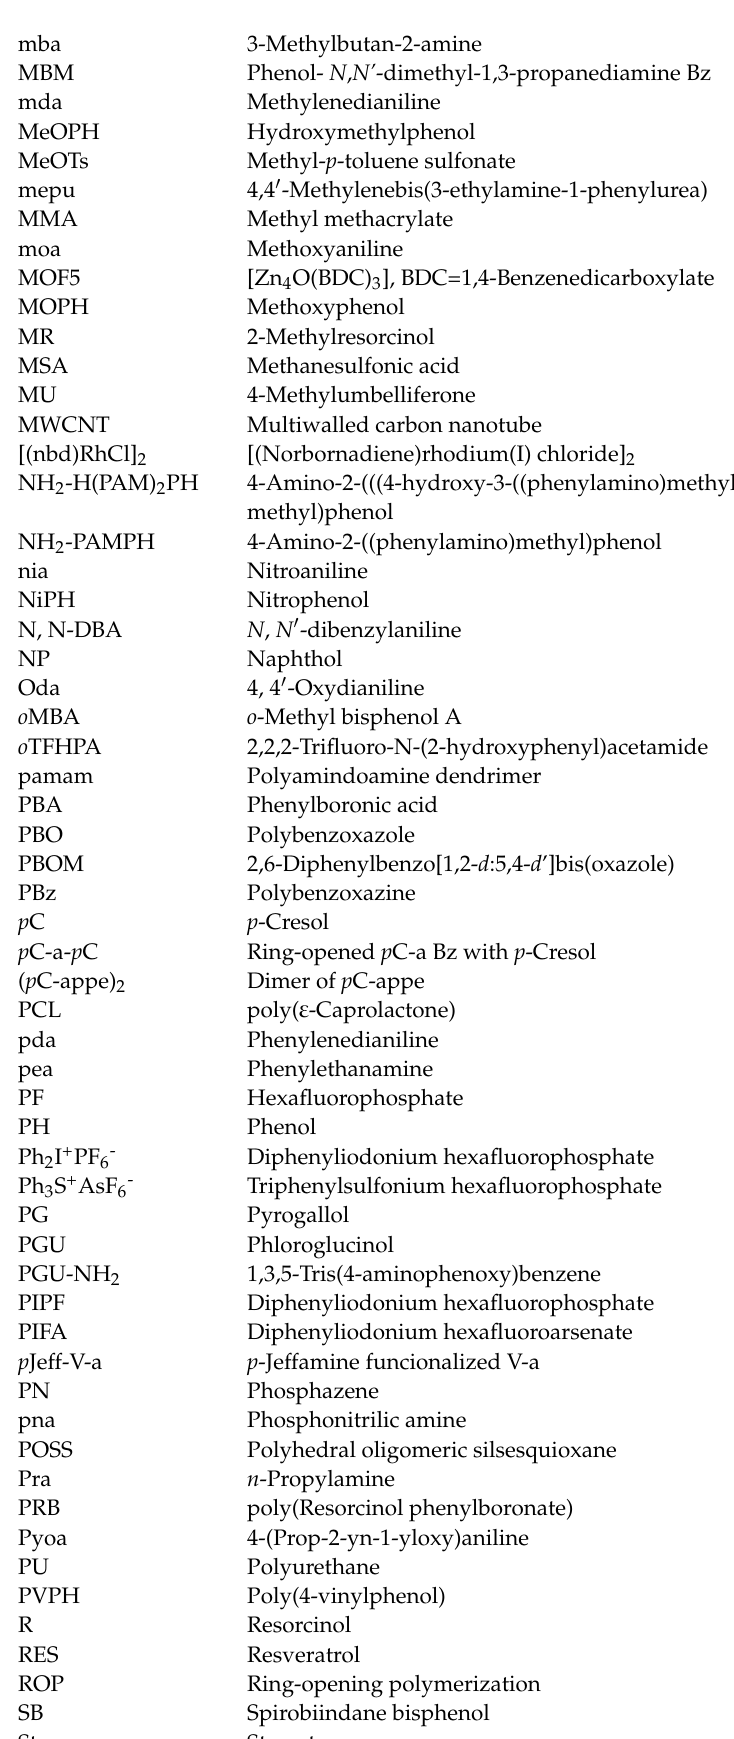
Figure 56. ( a ) Dimer 1 packing structure [80]. Copyright 2001. Reproduced with permission from American Chemical Society. ( b ) Self-termination of ring opening reaction of p -substituted phenol- based Bz